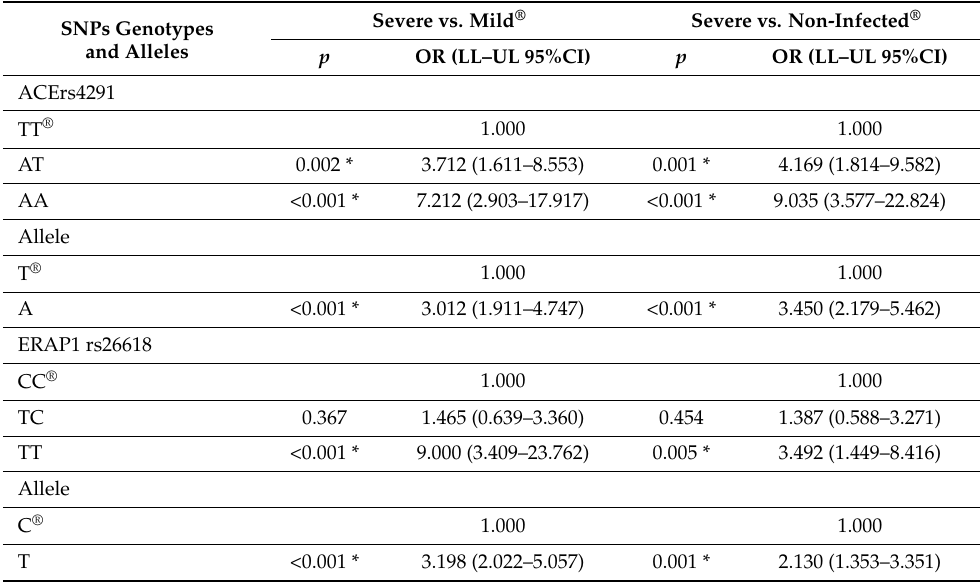
Table 4. Univariate analysis for severe cases regarding different SNPs, genotype and allele. SNPs Genotypes and